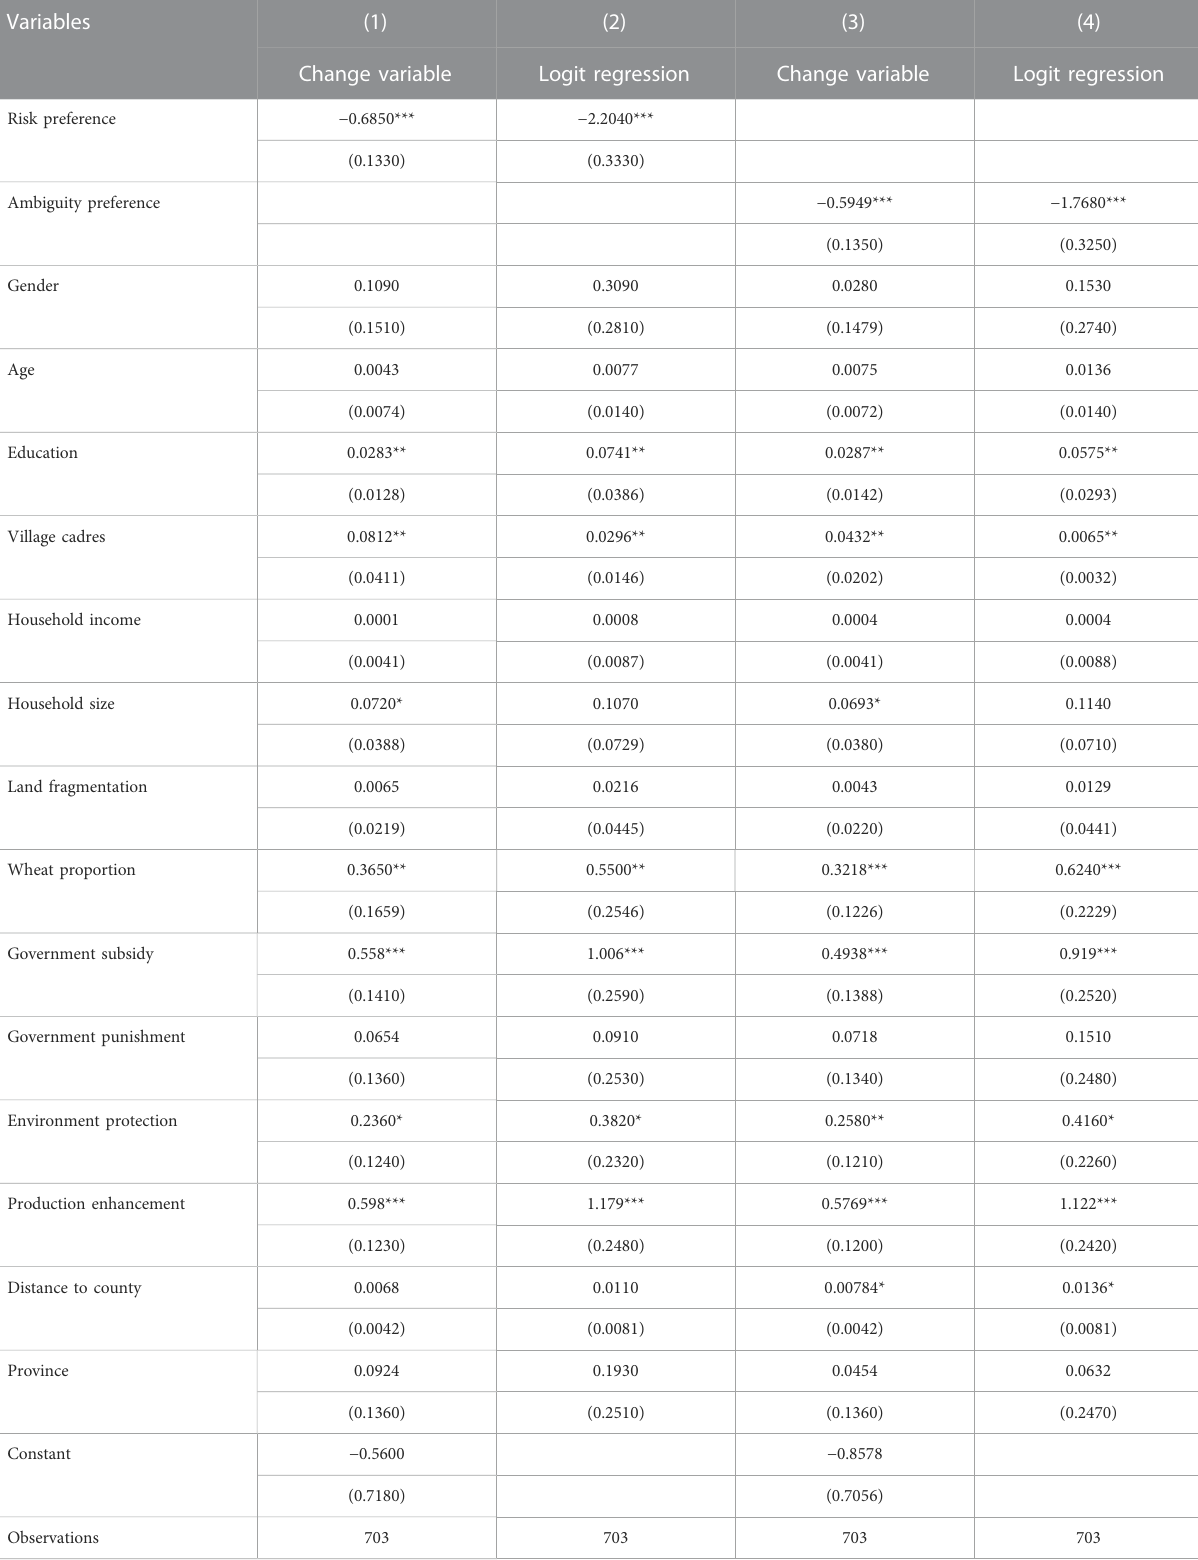
TABLE 7 Results of the robustness